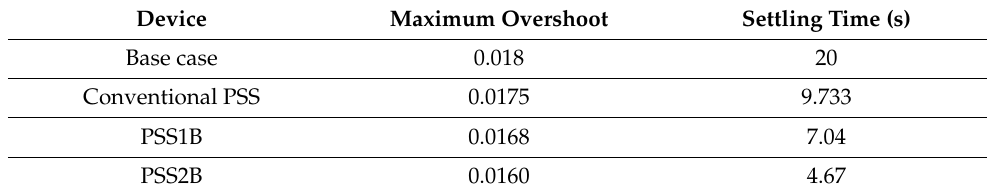
Table 17. Maximum overshoot and settling time of rotor speed at heavy